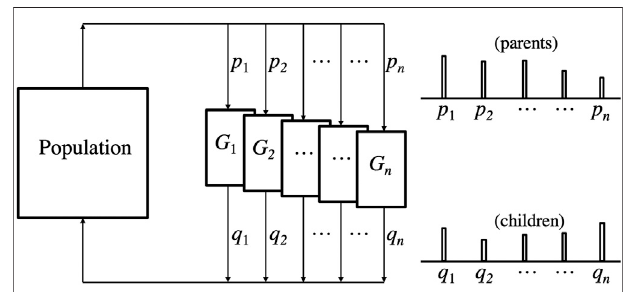
FIGURE 2 | A simple sketch of biological evolution. Consider a population of individuals who can be described as having certain genotypes , G 1 , ... , G n with proportions p 1 , ... , p n . The genotype of each individual determines its phenotype (not shown) which determines the proportions q 1 , ... , q n , of the genotypes surviving into the population of the next generation. The two histograms (parents and children) illustrate distributional change from one generation to the next. Over many generations, new genotypes may become dominant, while others become rare or disappear